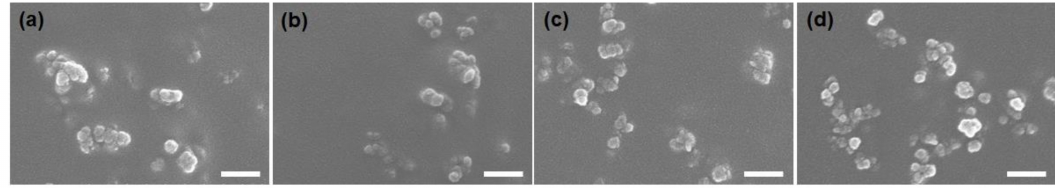
Figure 1. SEM images of ( a ) NDs, ( b ) NH 2 -NDs, ( c ) ICA (10 µ g)-NDs, and ( d ) ICA (50 µ g)-NDs. Scale bar: 200